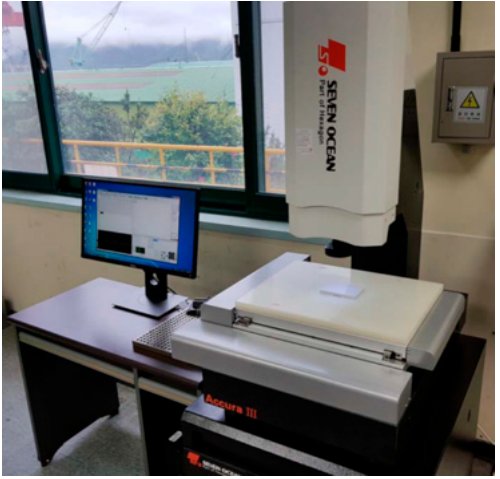
Figure 10. Videometer for measuring the toe angle.